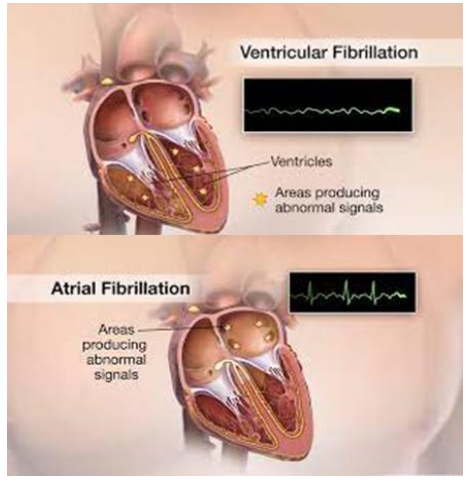
Figure 4. Ventricular and Atrial Signals of the Heart [36].